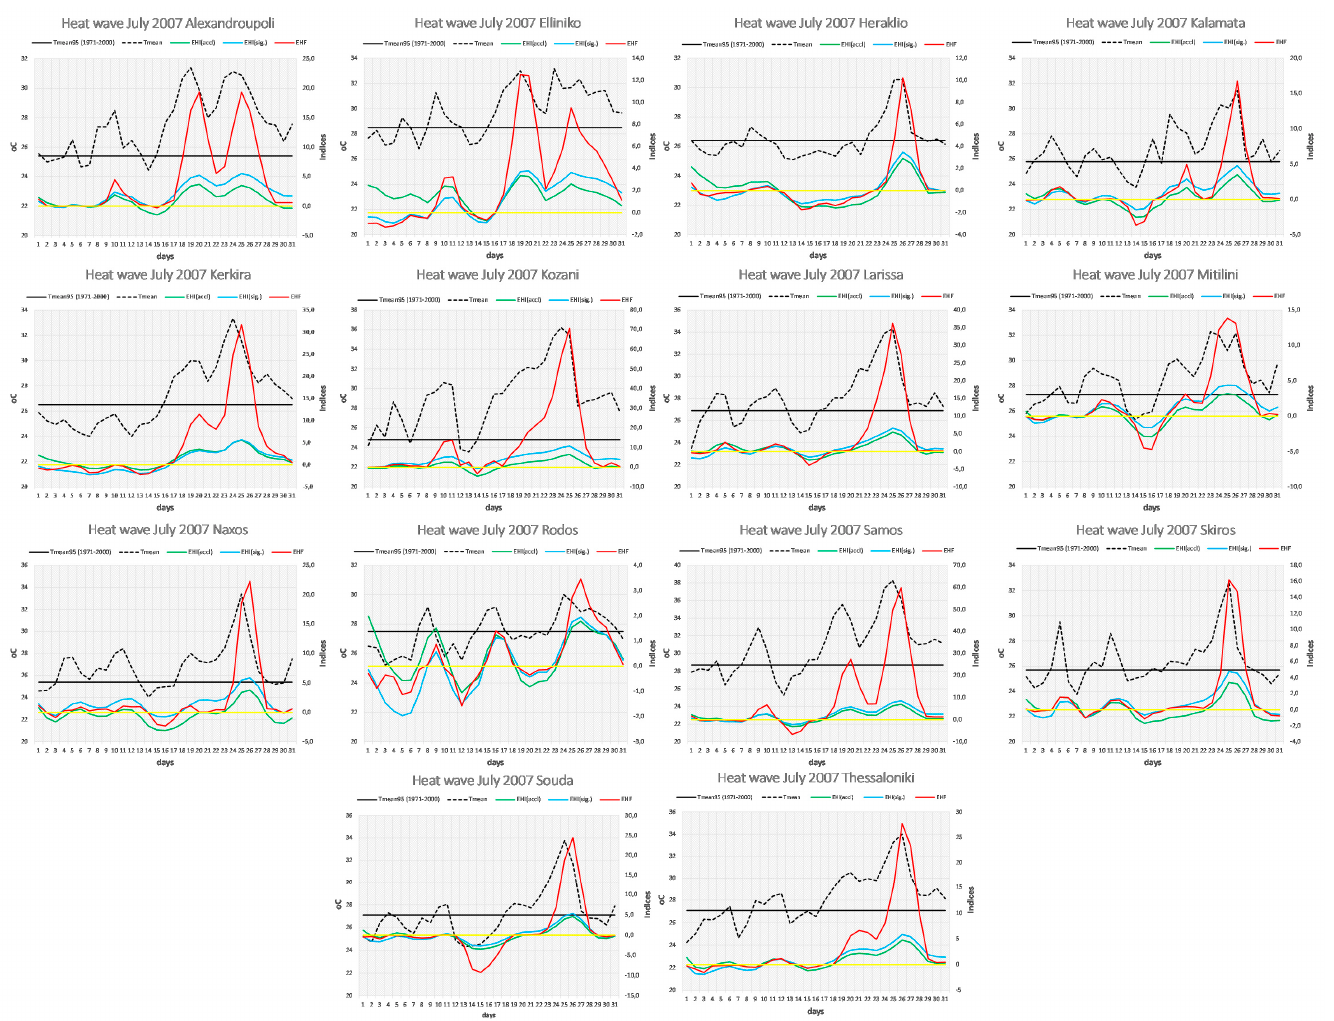
Figure 5. Same description as in Figure 4 but for the heat wave of July 2007 in